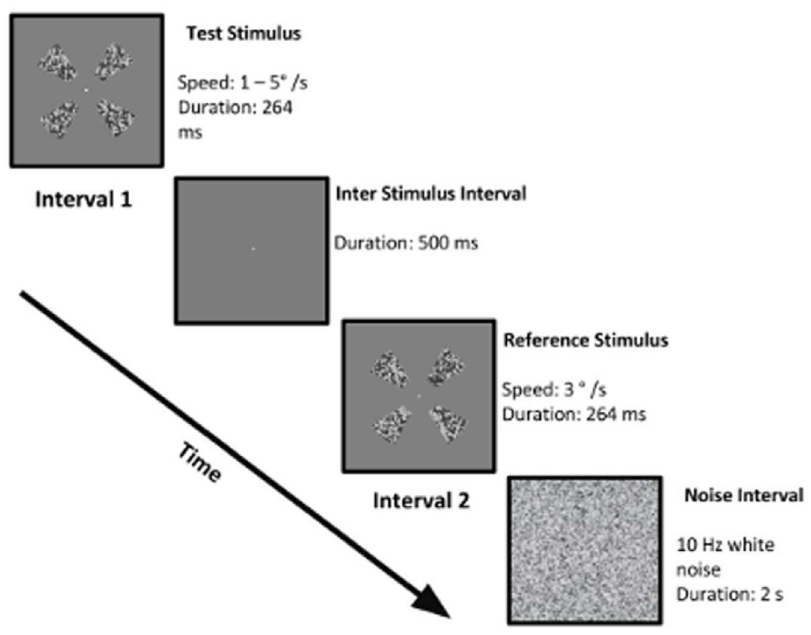
Fig. 2. A schematic diagram of the two interval stimulus presentation sequence. In one interval was the test stimulus which consisted of Gabor elements all moving at a speed between 1–5 ˚ /s. In the other interval a reference stimulus was presented that consisted of Gabor elements moving at 3 ˚ /s. Both intervals were separated by an inter stimulus interval of 500 ms in which the screen was mid gray set to the background luminance. The task of the observer was to indicate the interval containing the fastest motion. After the presentation of both intervals, dynamic white noise was presented.